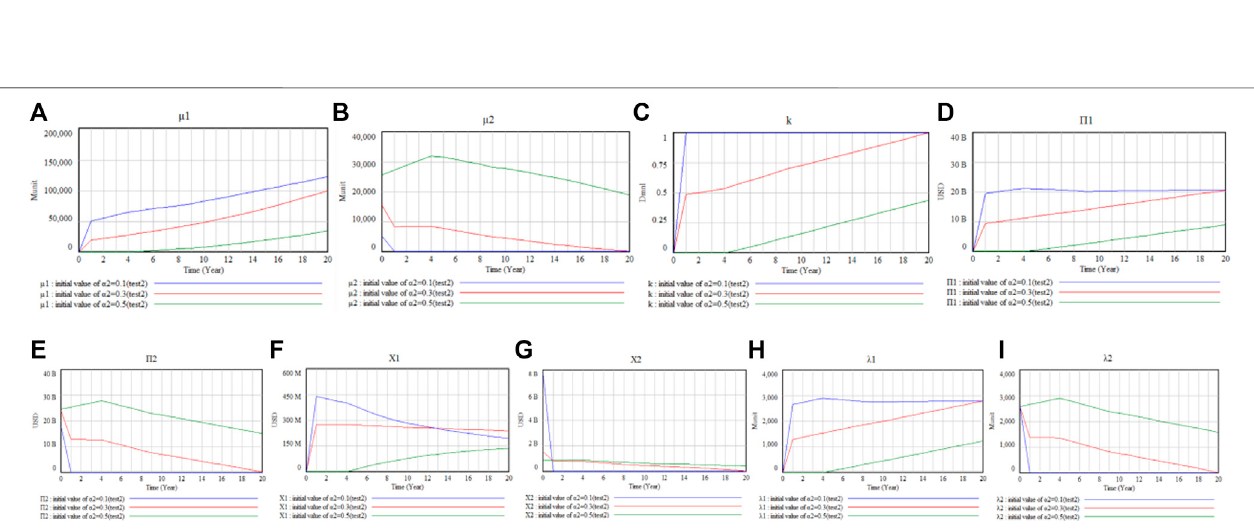
FIGURE10| Changes inthefactors aspreferencevaries: (A) Thechange of μ 1; (B) Thechange of μ 2; (C) Thechange ofk; (D) The changeof Π 1; (E) :The change of Π 2; (F) The change of X1; (G) The change of X2; (H) The change of λ 1; (I) The change of λ 2.